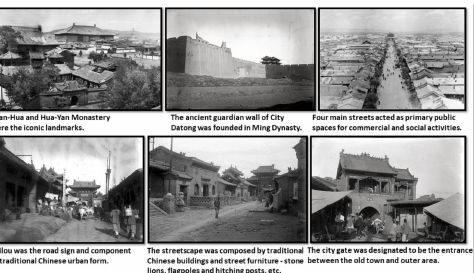
Figure 4. The basic urban form of the city Datong was formed during the Ming and Qing Dynasties. Source: Datong City Planning and Design Institute,